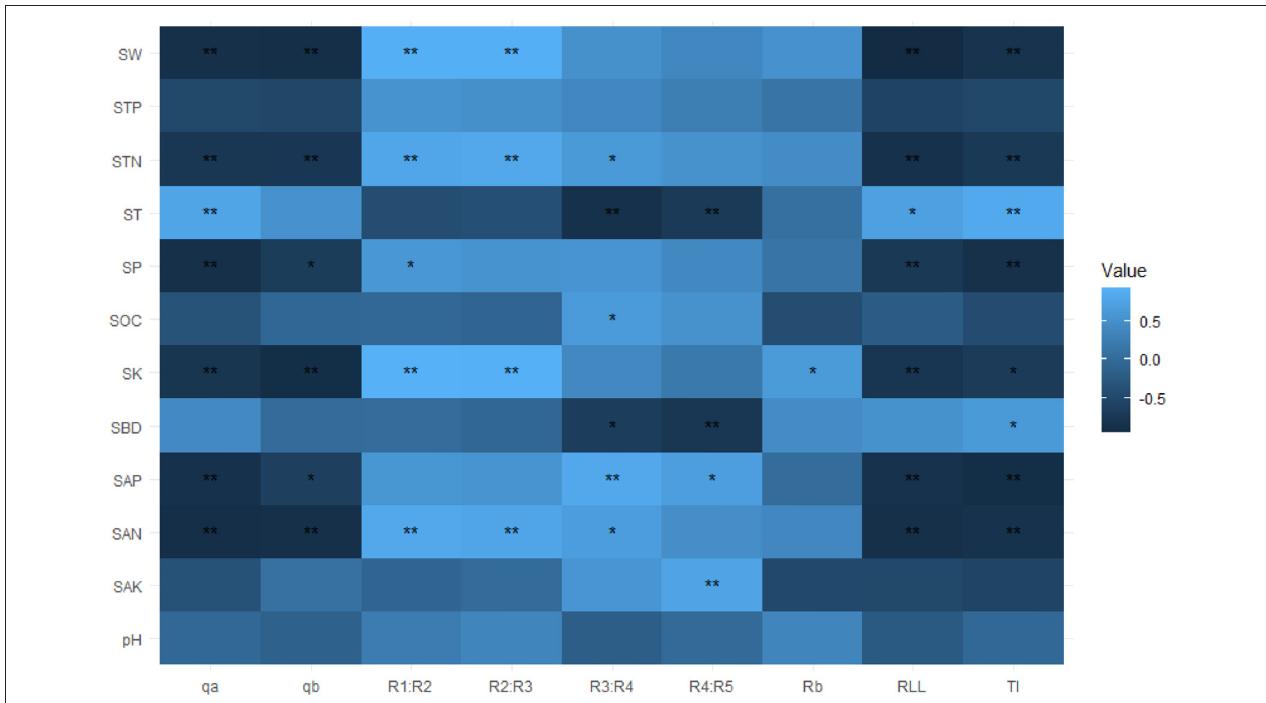
FIGURE 4 | Correlation coefficients between RSA (root system architecture) and soil physicochemical parameters. The red and blue colors denote significant positive and negative effects, respectively. The color intensity is proportional to the magnitude of the Pearson correlation. The darker the color, the greater the strength of the relationship, and vice versa. The RSA index variables are TI, topological index; q a and q b , revised topological index; RLL, root link length; R b , root branch rate; R i :R i + 1 , gradual root branch rate. The soil parameters are ST, soil temperature; SW, soil water content; SBD, soil bulk density; SP, soil porosity; pH, soil pH; SOC, soil organic carbon; STN, soil total nitrogen; STP, soil total phosphorus; SK, soil total potassium; SAN, soil available nitrogen; SAP, soil available phosphorus; SAK, soil available potassium. The * and ** indicate significance at p < 0.05 and p < 0.01,